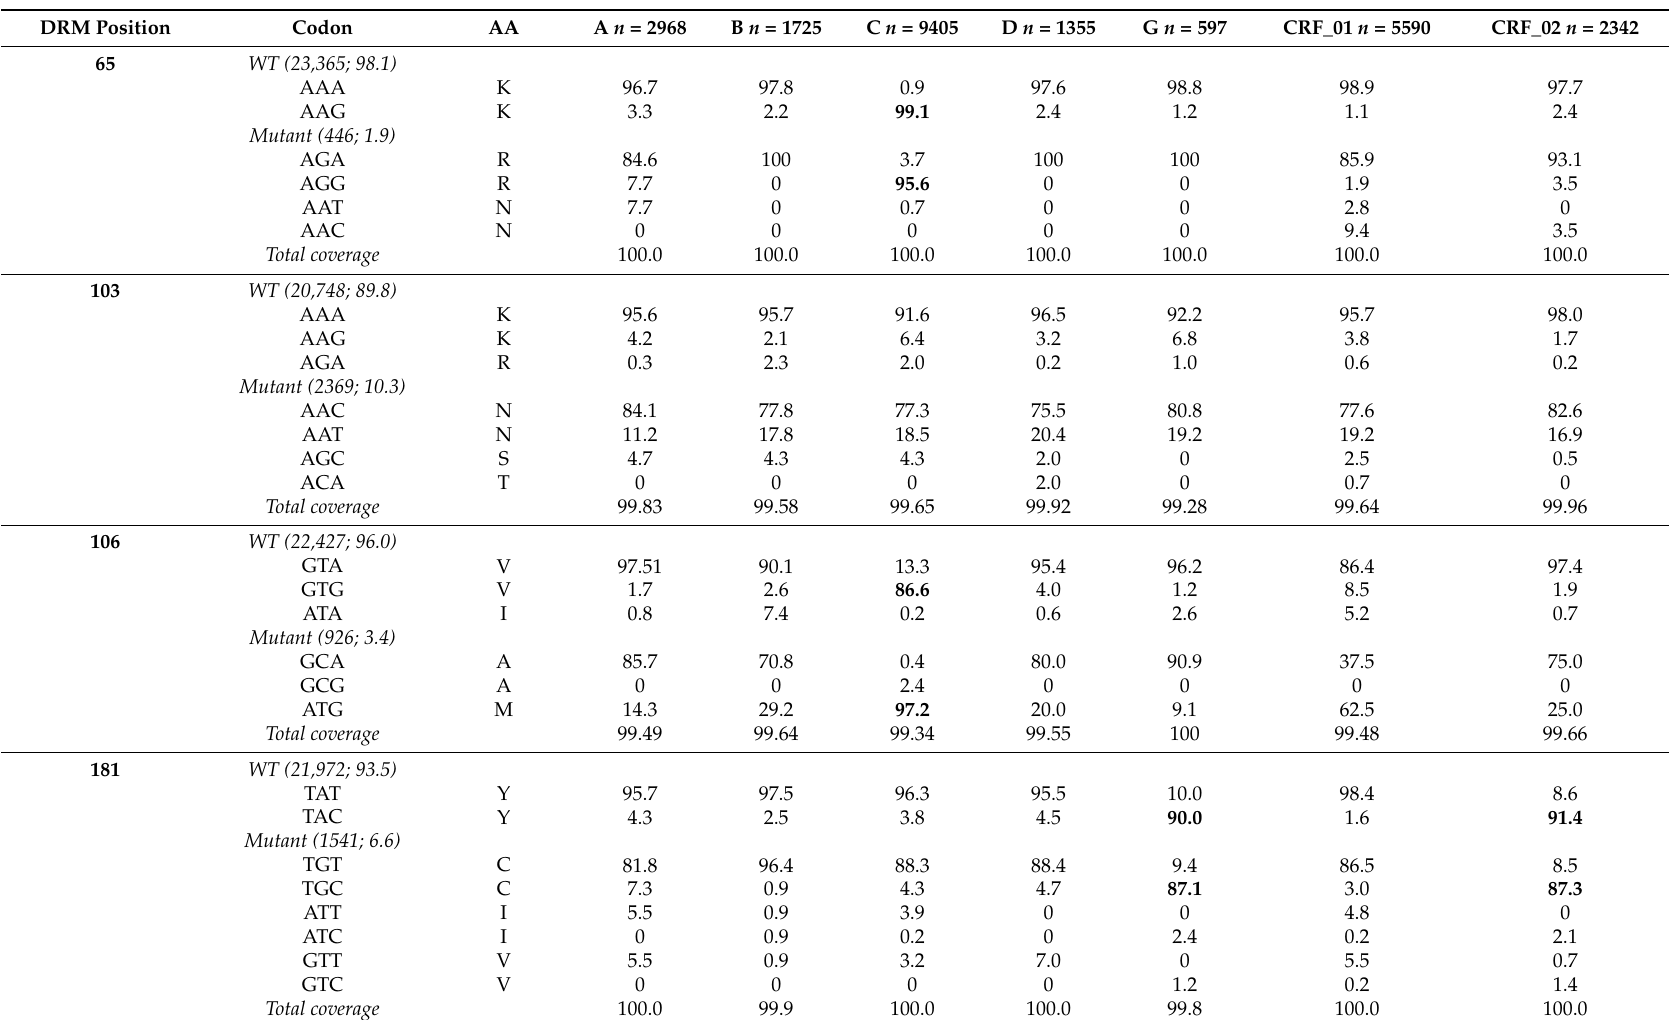
Table 1. Wild type and mutant codon frequency by